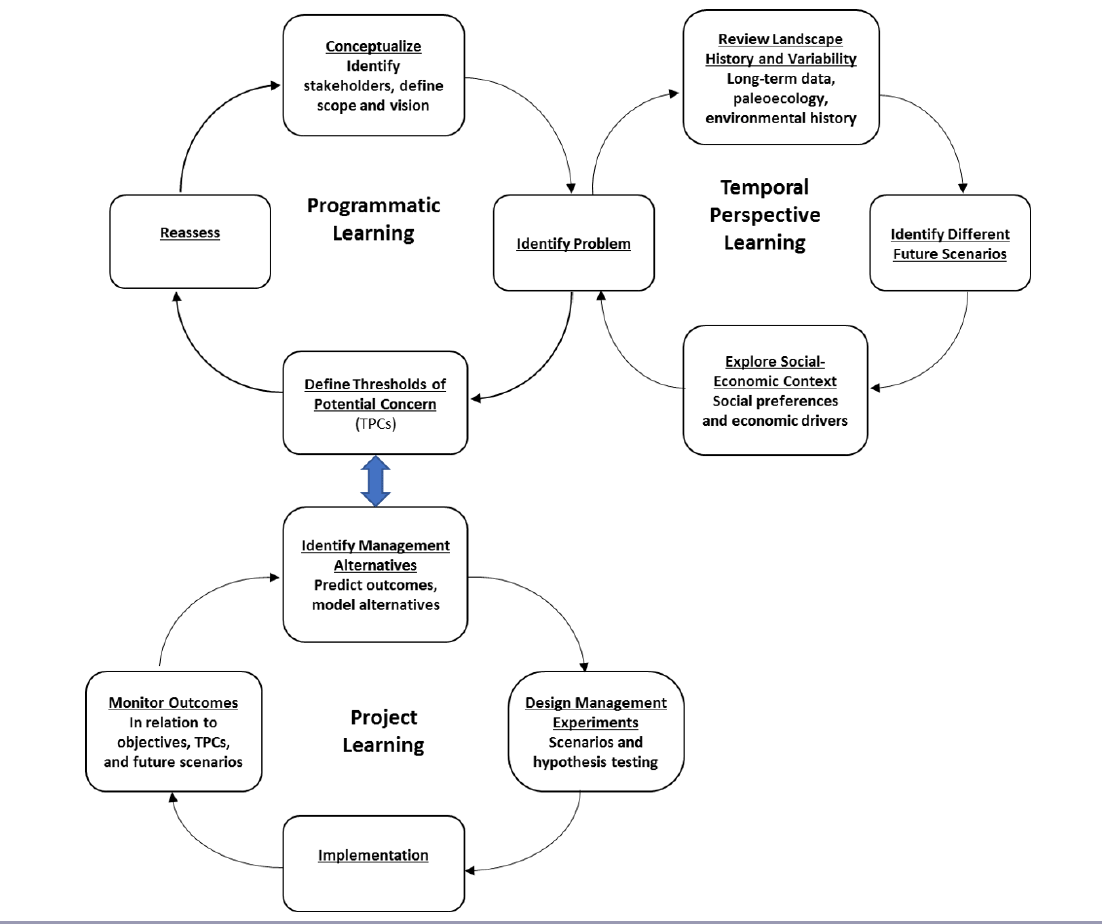
Fig. 2 . Adaptive management planning strategy that incorporates programmatic, temporal perspective, and project learning cycles, enabling the historical range of variability and future projections to be incorporated into thresholds of potential concern (Gillson and Marchant 2014, Gillson